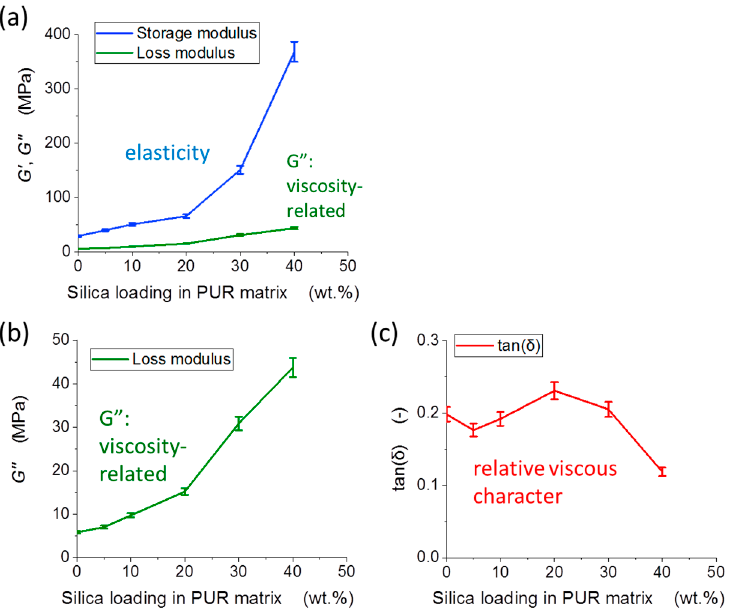
Figure 8. DMTA trends: storage moduli G’ ( a ), loss moduli G” ( b ), and tan( δ ) ( c ) as function of nanofiller loading, all measured at T = 25 °C.